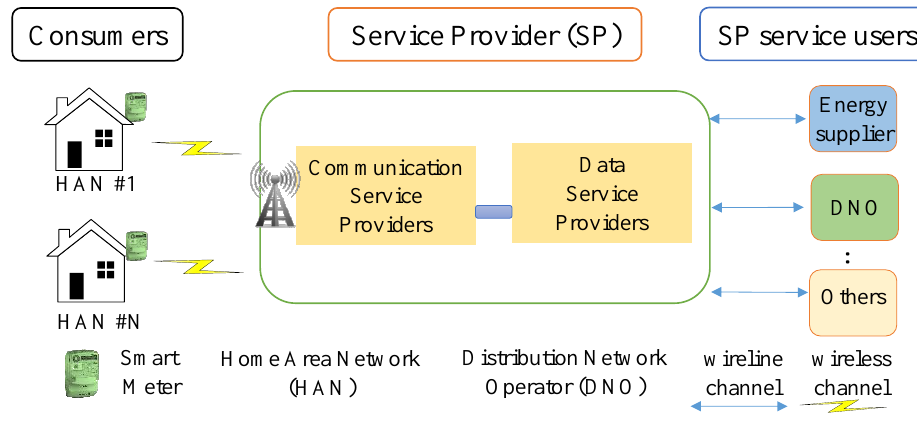
Figure 1. Smart Metering